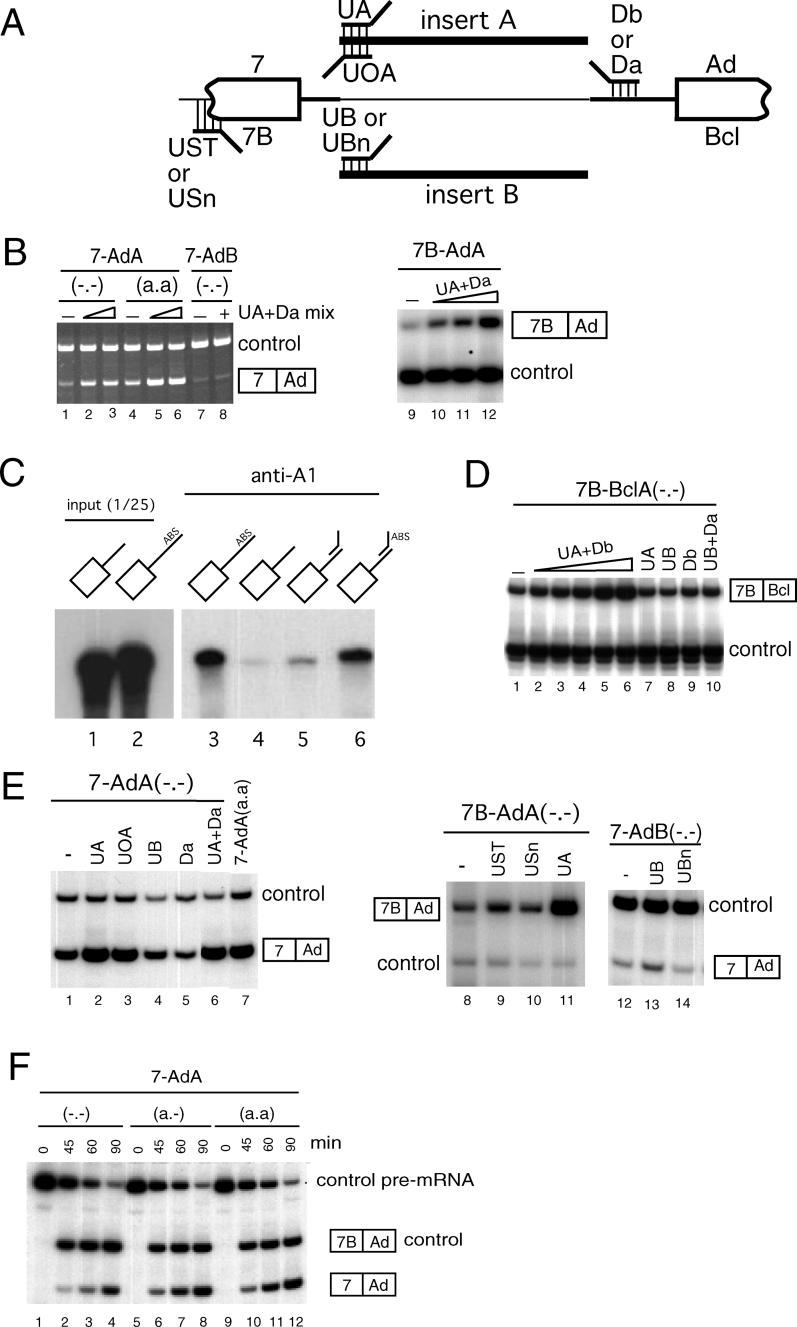
Antisense Oligonucleotides Carrying ABS Stimulate the Splicing of Large Introns(A) Schematic representation of model large-intron pre-mRNAs and the position and structure of the RNA oligonucleotides. Oligonucleotides UA and UB form a duplex with sequences located 46–65 and 46–64 nt, respectively, downstream from the 5′ splice site. Oligonucleotides Db and Da, respectively, hybridize 123–142 nt and 68–87 nt upstream of the 3′ splice junction.(B) The 7-AdA pre-mRNA lacking ABS (−.−) or containing ABS (a.a) was incubated in a HeLa extract in the absence (lanes 1 and 4) or in the presence (lanes 2 and 3, and lanes 5 and 6) of UA and Da oligonucleotides (16 and 40 nM of each oligonucleotide). The 7-AdB pre-mRNA (−.−) and the 7B-AdA pre-mRNAs were also incubated in the presence of UA and Da (40 nM in lane 8, and 0.08, 0.8, and 8 nM in lanes 10–12, respectively). As internal control for splicing, a smaller quantity of the small-intron 7B-Ad pre-mRNA (lanes 1–8) or the small-intron 7-Ad pre-mRNA (lanes 9–12) was co-incubated with the test substrates. Incubation in HeLa extracts was for 60 min.(C) Labeled transcripts corresponding to the first 196 of the 7-AdA(−.−) pre-mRNA (lanes 1, 4, 5, and 6) or the first 237 nt of the ABS-containing 7-AdA(a.a) pre-mRNA (lanes 2 and 3) were incubated in a HeLa nuclear extract in the presence of 100 pM of the ABS-lacking UAn oligonucleotide (lane 5) or the ABS-containing UA (lane 6). Mixtures were immunoprecipitated with an anti-hnRNP A1 antibody and resolved in a denaturing 5% polyacrylamide gel. The initial input for each transcript representing 1/25th of the total amount is shown in lanes 1 and 2.(D) The 7B-BclA was co-incubated with 100-fold less of the small-intron 7-Ad control pre-mRNA and increasing amounts of the UA and Db oligonucleotide mixture (0, 0.08, 0.8, 8, 80, and 160 nM) or with 160 nM of individual or mixtures of various oligonucleotides.(E) The 7-AdA pre-mRNA was co-incubated with the small-intron 7B-Ad pre-mRNA in a HeLa nuclear extract for 90 min at 30 °C. Each oligonucleotide was used at a concentration of 160 nM. The 7-AdA(a.a) pre-mRNA containing cis-acting ABS elements was used as a control (lane 7). In lanes 8–11, the 7B-AdA pre-mRNA was co-incubated with the small-intron 7-Ad pre-mRNA and 80 nM of oligonucleotides. In lanes 12–14, the 7-AdB pre-mRNA was co-incubated with the 7B-Ad control pre-mRNA and either the UB or UBn (40 nM each). UBn carries a non-ABS tail. Incubation was for 60 min in a HeLa extract.(F) The control 7B-Ad pre-mRNA was co-incubated with 7-AdA pre-mRNA containing either no ABS (−.−), only the upstream ABS (a.−), or two ABS (a.a). Incubation in HeLa extracts was for 0, 45, 60, and 90 min. RT-PCR assays performed with a single pair of primer allows amplification of the unspliced control pre-mRNA, as well as mRNA products derived from both the control and the 7-AdA derivatives.